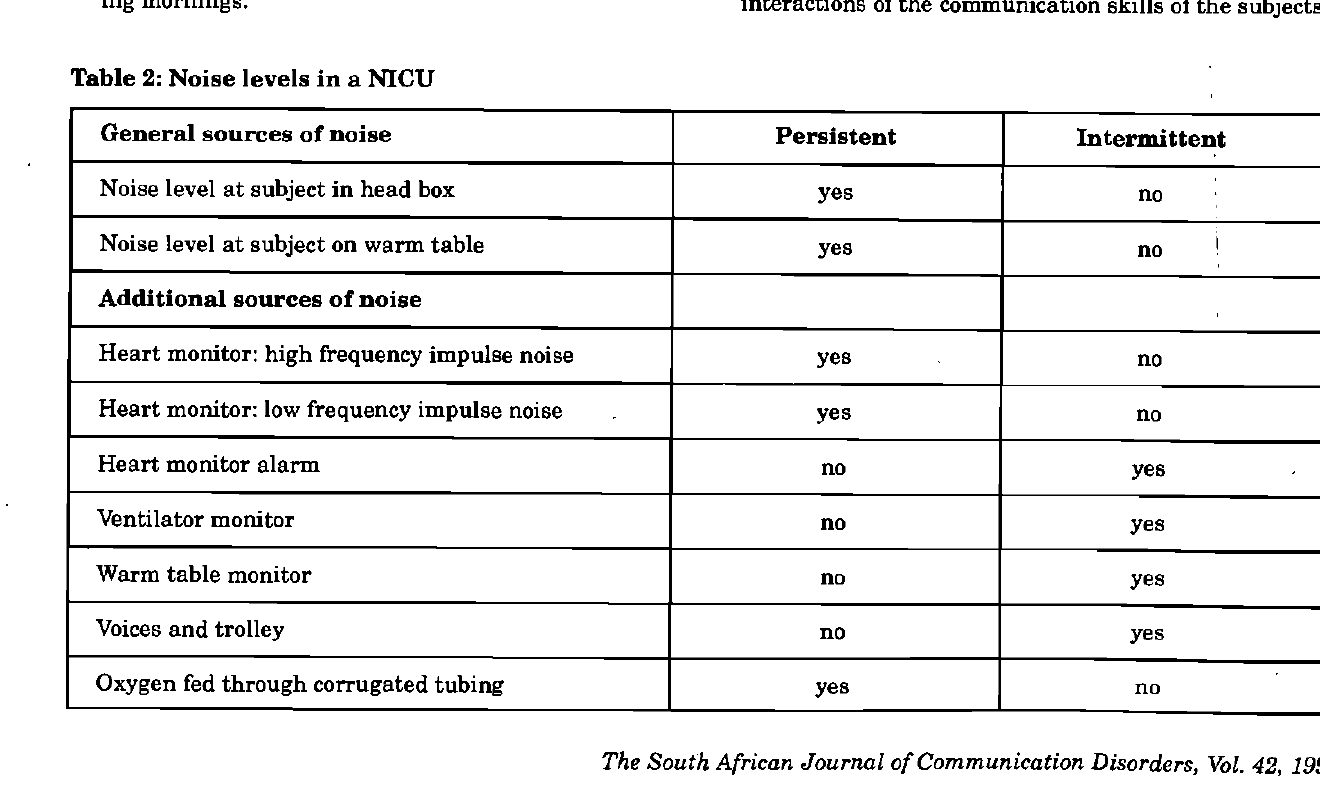
Table 2: Noise levels in a